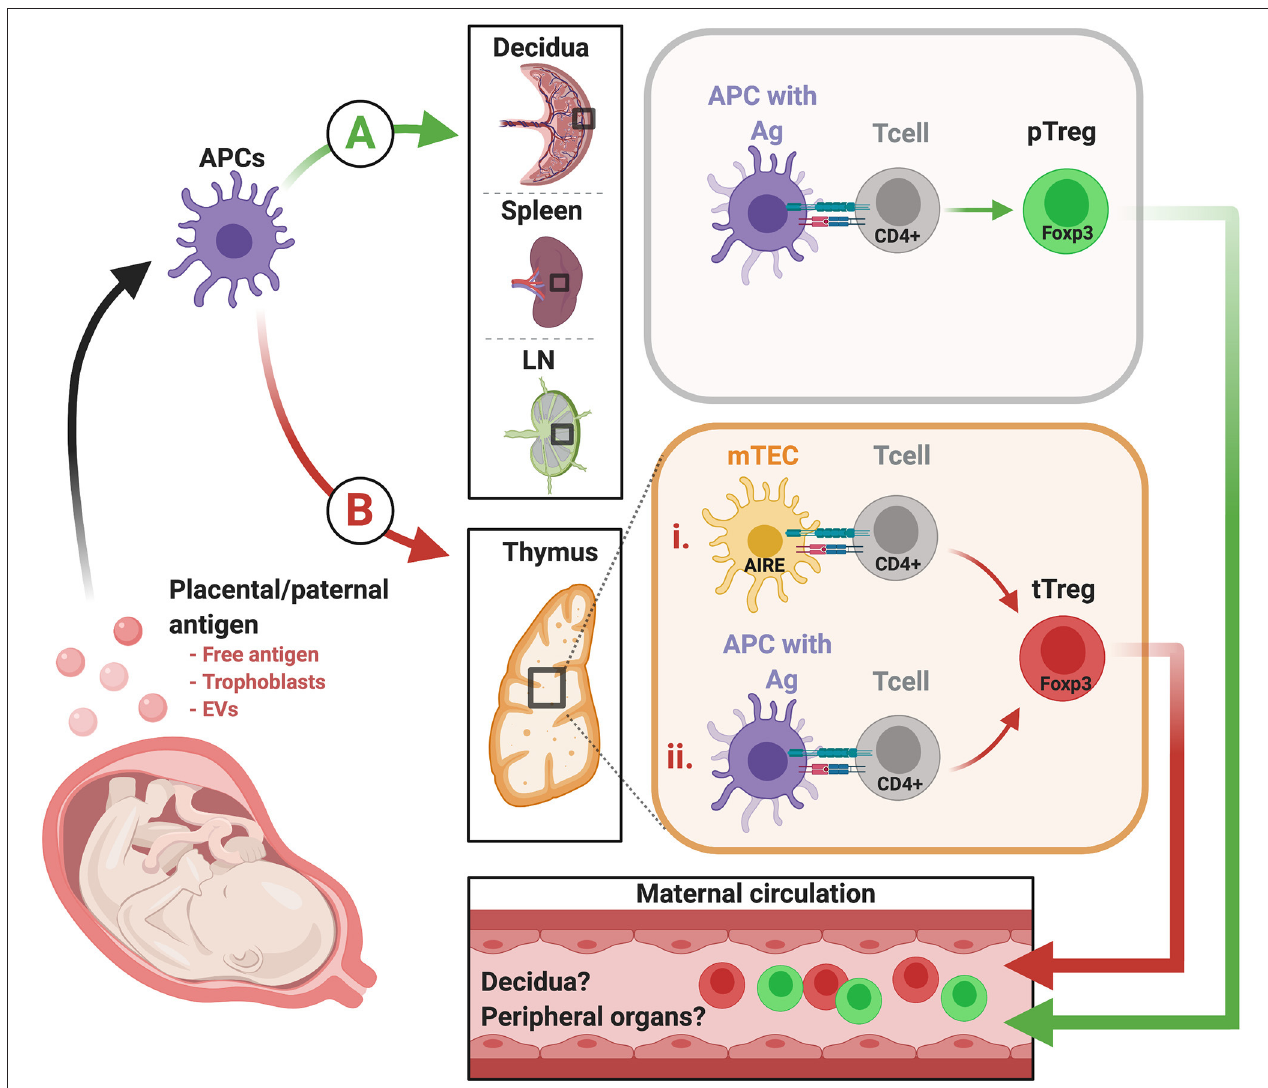
FIGURE 1 | Proposed model of how fetus-specific and paternally-inherited antigens can contribute to pT Reg and tT Reg development. Fetal and placental antigens that elicit maternal T cell reactivity include those that are paternally-inherited and thus foreign to the maternal immune system, and may also include antigens restricted to fetal and placental tissues. These antigens may arise from chorionic villi, extravillous trophoblast cells, or both, and can be released in the form of whole cells (microchimerism), EVs, and/or as free soluble antigen. From there, placental antigens may prompt T Reg development in either or both of two possible pathways. (A) Placental antigens may be presented by maternal APCs in the decidua, and/or drain into maternal blood and lymphatic vessels to access the spleen and uterus-draining LN. At these sites, they can be processed and indirectly presented in the context of maternal MHC to elicit fetal antigen-specific pT Reg . (B) It is also possible that tT Reg are elicited in the thymus via two potential mechanisms. (i) Placenta/fetus-specific antigens may be expressed and presented directly by mTECs under the control of Aire. (ii) Alternatively, these antigens, and/or placentally-derived antigens accessing the thymus via the vasculature, may be indirectly presented via resident APC in the thymus. EVs, extracellular vesicles; APC, antigen presenting cells; LN, lymph nodes; MHC, major histocompatibility complex; pT Reg , peripherally-induced T Reg ; tT Reg , thymus-derived T Reg . Created with